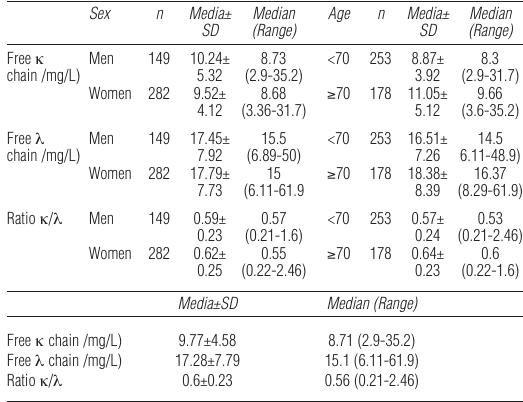
Table. Parameters by gender and age groups with cutoff at 70